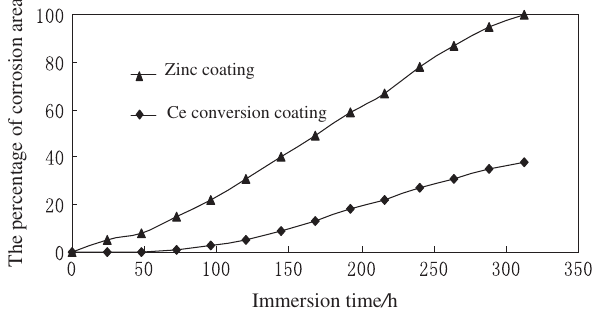
Figure 1: The relationship between the immersion time and the percentage of corrosion area for zinc coating and Ce conversion coating in a 5% NaCl